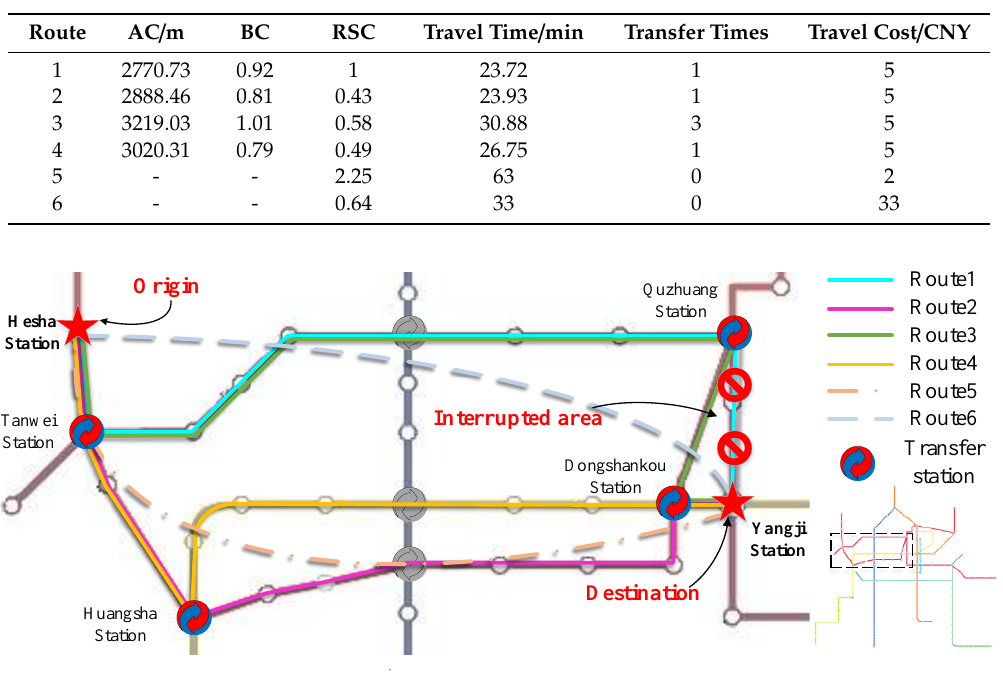
Table 3. Route attributes from HS to YJ.